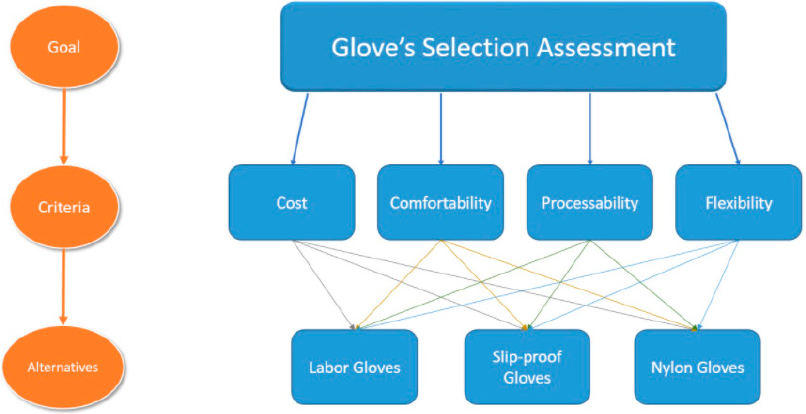
Figure 4. Multi-criteria decision making for glove’s selection assessment. Table 3. Multi-criteria consideration.